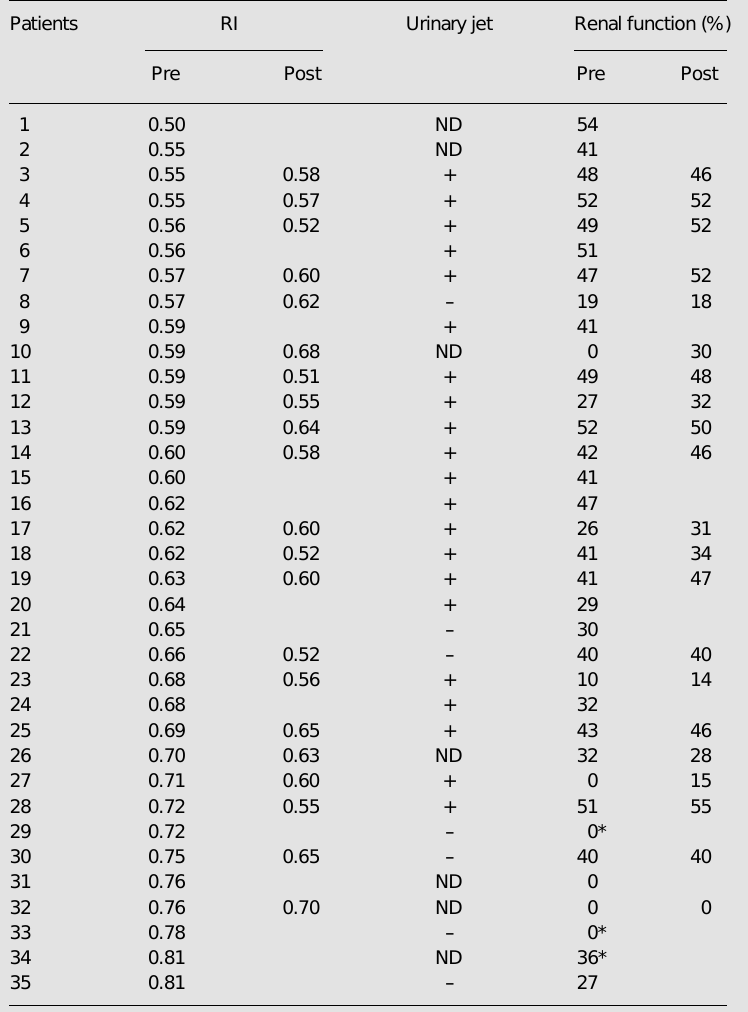
Table 4. Doppler ultrasonography: resistive index (RI) pre- and post-relief of obstruc- tion, presence of urinary jet and percent renal function.